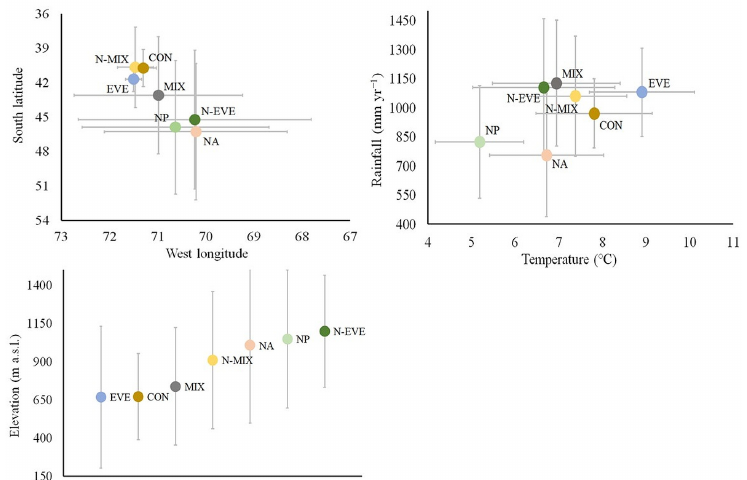
Figure A2. Characterization of Patagonian forest types in Argentina (see Table 1) classified by degrees of latitude vs. longitude, mean annual temperature (°C) vs. mean rainfall (mm yr − 1 ), and elevation occurrence (m a.s.l.). Bars indicate the standard deviation of each axis.